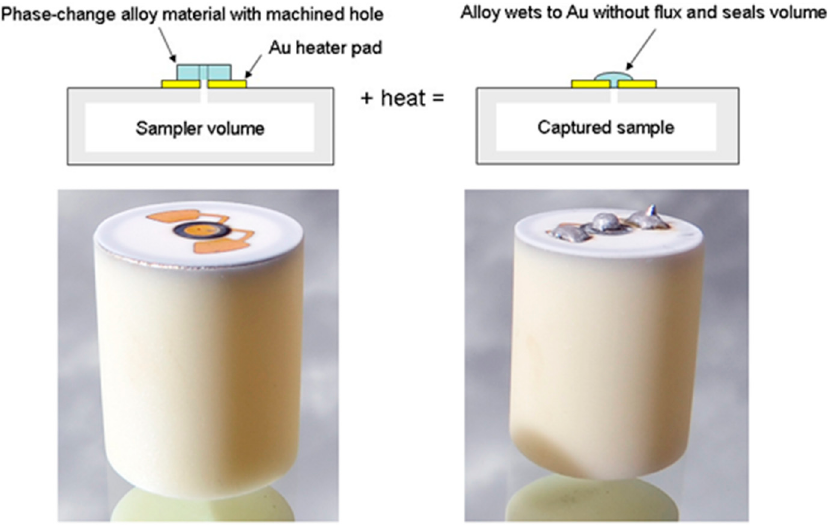
Figure 19. Cross-section and photographs of μ Sampler and μ Valve, from [218] with permission.